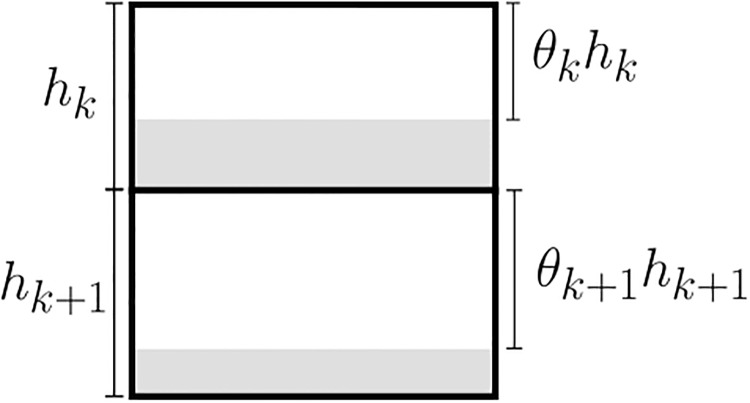
The porosity parameter.Illustration of the porosity parameter θ for two adjacent depth layers in a specific horizontal position. The thickness of depth layer k is denoted by hk. The gray regions indicate the total volume occupied by one or more objects in the cell. The unoccupied volume fraction is denoted by θk, θk+1. This fraction is used to modify the available water volume used in the calculations.